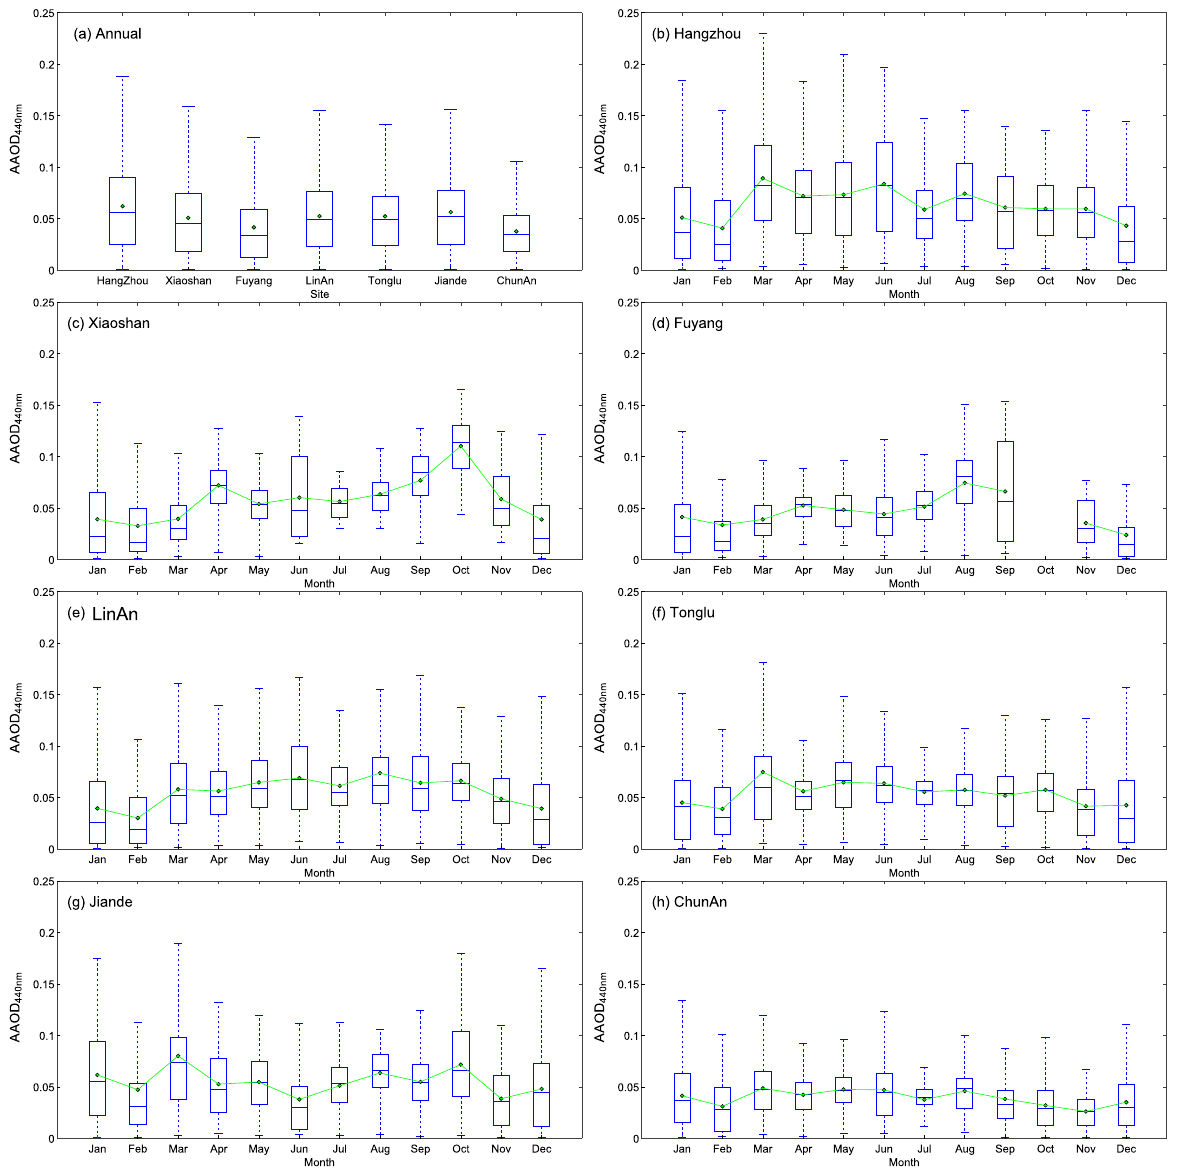
Figure 5. (a) Annual average absorption aerosol optical depths at 440nm (AAOD 440nm ) at the CARSNET sites and month-to-month variations in AAOD 440nm at (b) Hangzhou, (c) Xiaoshan, (d) Fuyang, (e) LinAn, (f) Tonglu, (g) Jiande and (h) ChunAn. See Fig. 3 for an explanation of the